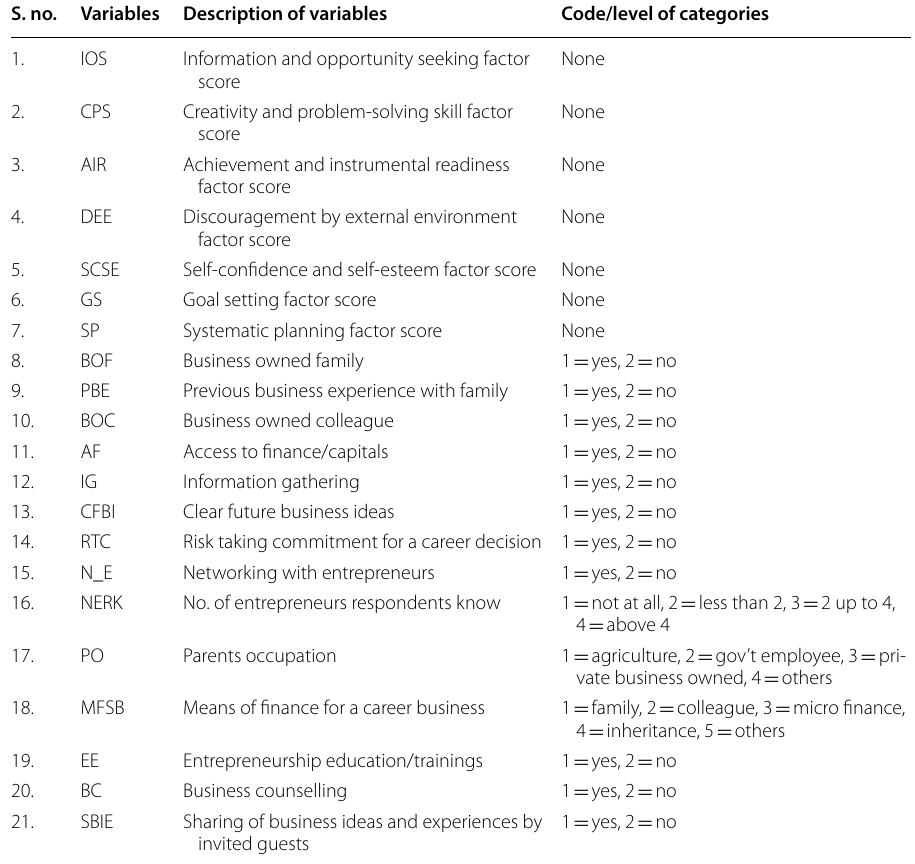
Table 1 Description of predictor